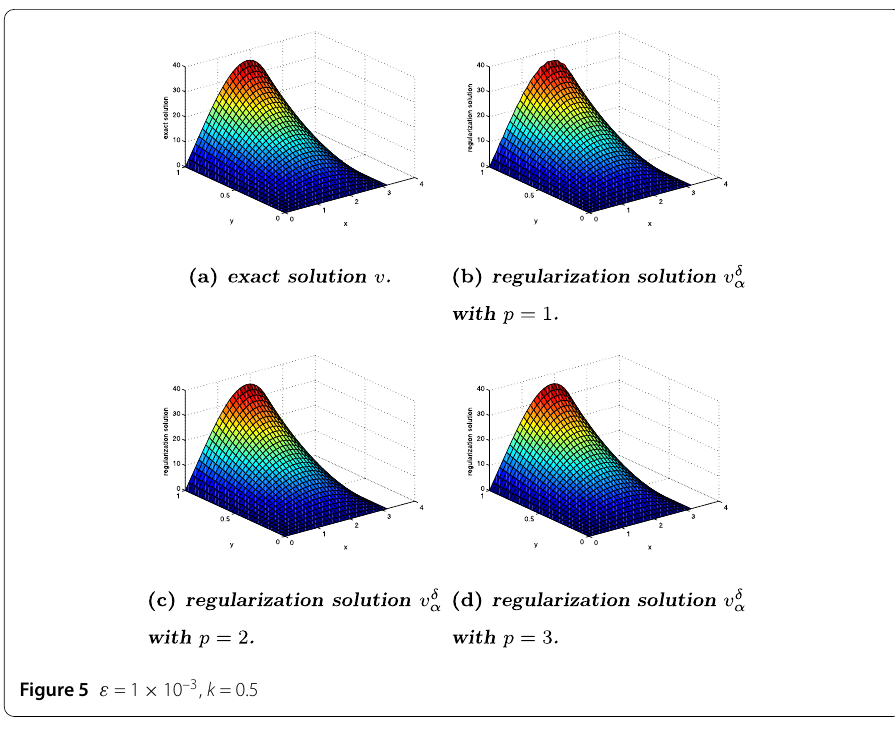
Figure 5 ε = 1 × 10 –3 , k = 0.5